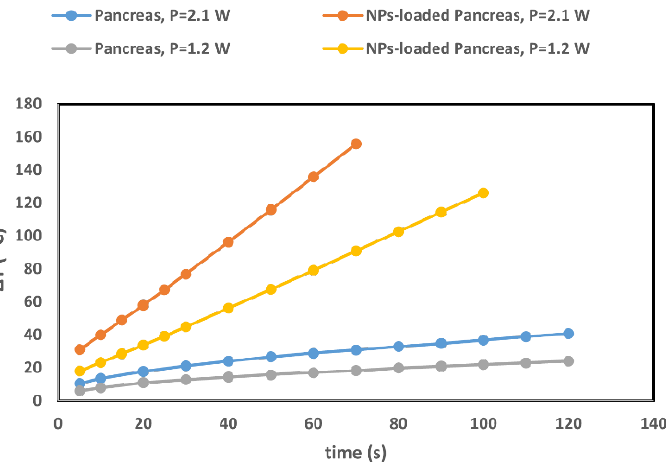
Figure 8. Temperature increases at 2 mm-hd from the light source in the pancreas tumor in the absence (gray and blue curves) and in presence of GNRs (yellow and orange curves), when exposed to laser irradiation, at two power values (1.2 W and 2.1 W) with laser applicator diameter of 0.3 mm.